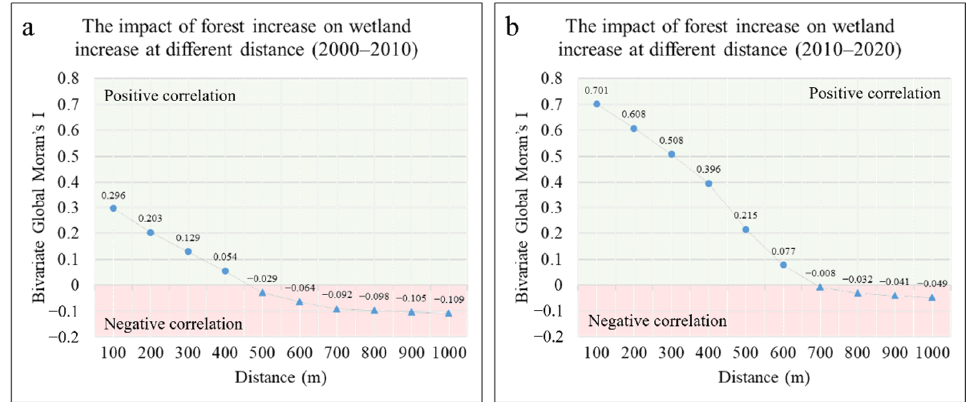
Figure 9. Bivariate Global Moran’s I between forest increase and wetland increase at different distance in Tianjin, from 2000–2010 ( a ), Bivariate Global Moran’s I between forest increase and wetland increase at different distance in Tianjin, from 2010–2020 ( b ).